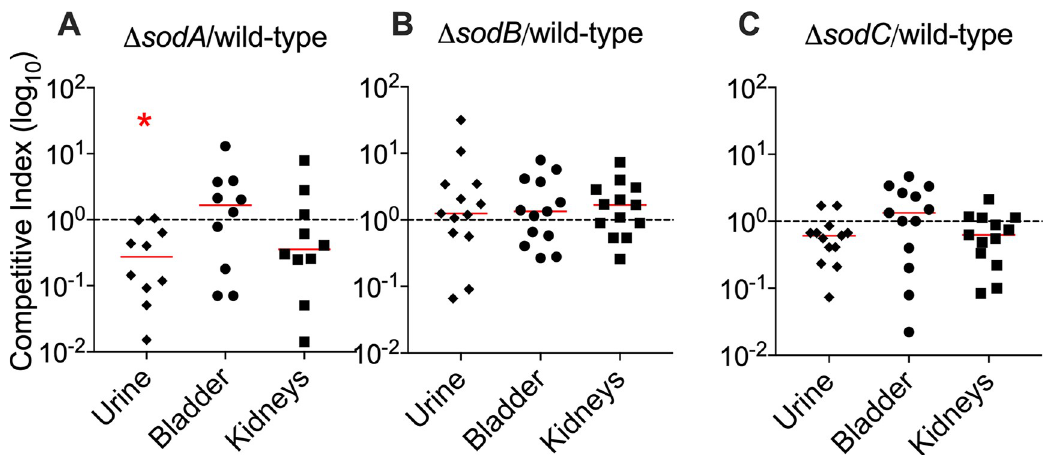
Fig 7. Role of sod genes in fitness of UPEC in the mouse model of UTI. Mice were inoculated with a mixture of wild-type strain and a mutant lacking sodA (A), sodB (B), or sodC (C) genes. Wild-type and mutant strains in the inoculum and tissue samples were enumerated. Competitive indices were calculated as the ratio of mutant to wild-type strain in vivo , and normalized to the ratio mutant to wild-type strain in the inoculum. Each symbol corresponds to results from a mouse, and bars indicate median. Dotted line, no loss of fitness in the mutant relative to parental wild-type strain (competitive index of 1). � P < 0 .05, Wilcoxon signed rank test.